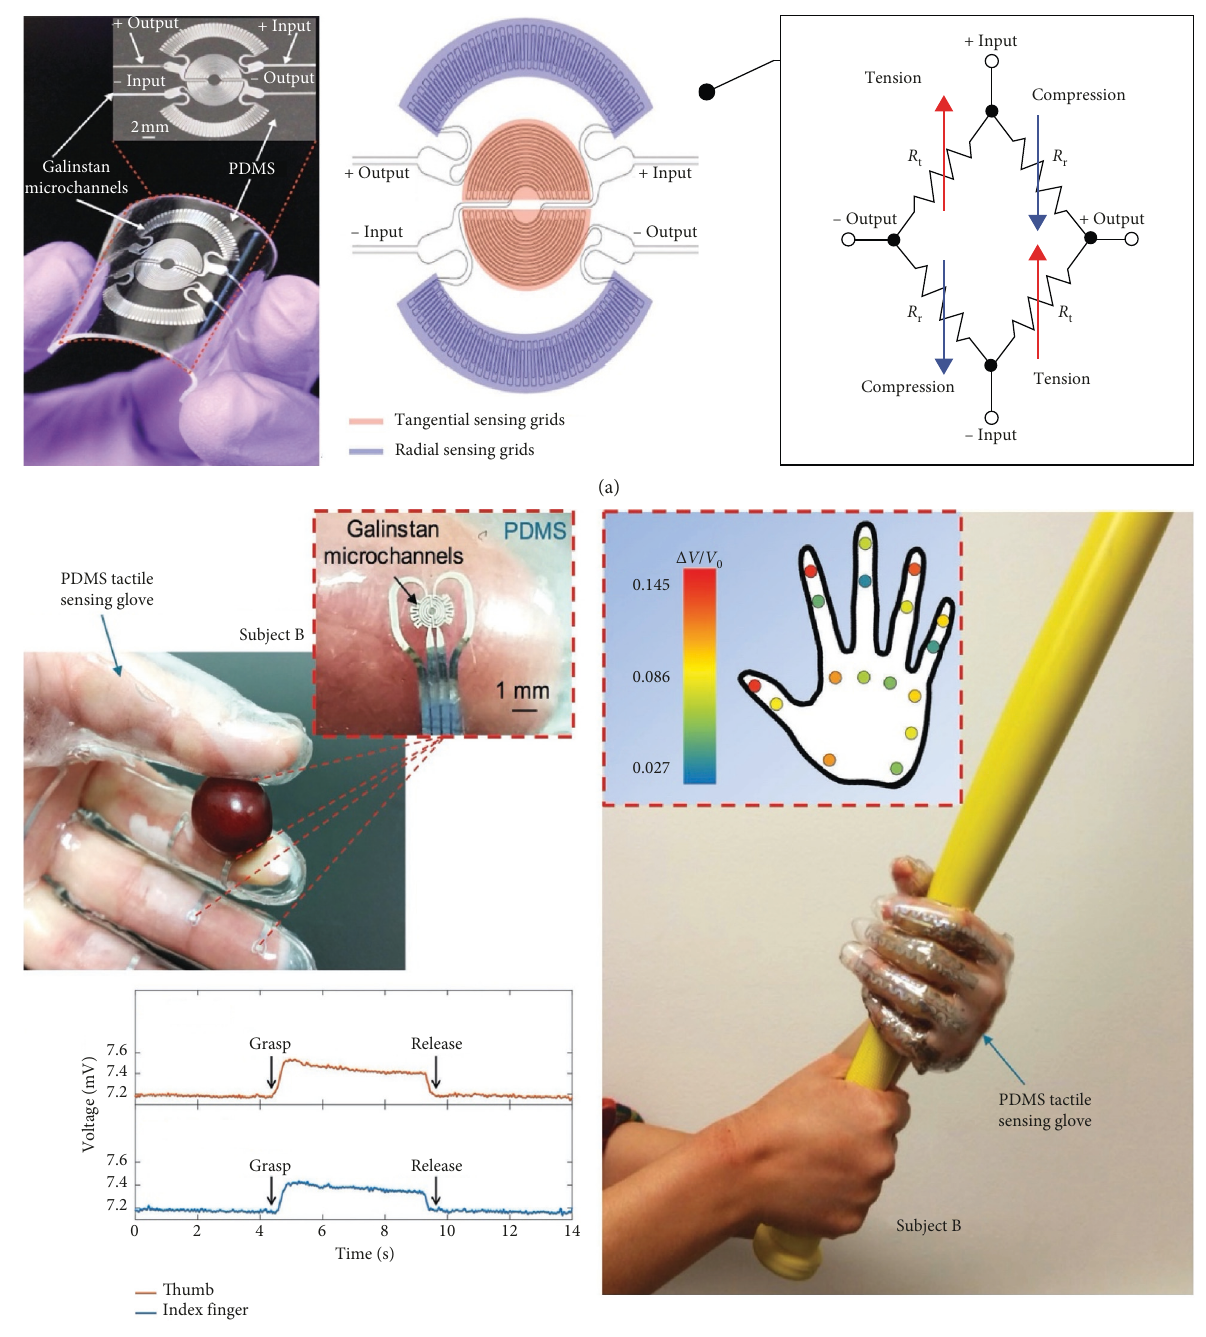
Figure 7: (a) Photograph of a microfluid tactile diaphragm pressure sensor (left). Optical image of demonstrated microfluidic diaphragm sensor (middle). Schematic circuit diagram of an equivalent Wheatstone bridge (right). (b) Photograph of tactile sensing gloves embedded on devices (top left), diagram showing the real-time response recorded during the motion of thumb and index while grasping and releasing grape (bottom left). Photograph of tactile sensor worn while grasping (adapted with permission from Ref. [99] copyright 2017, John Wiley publishing